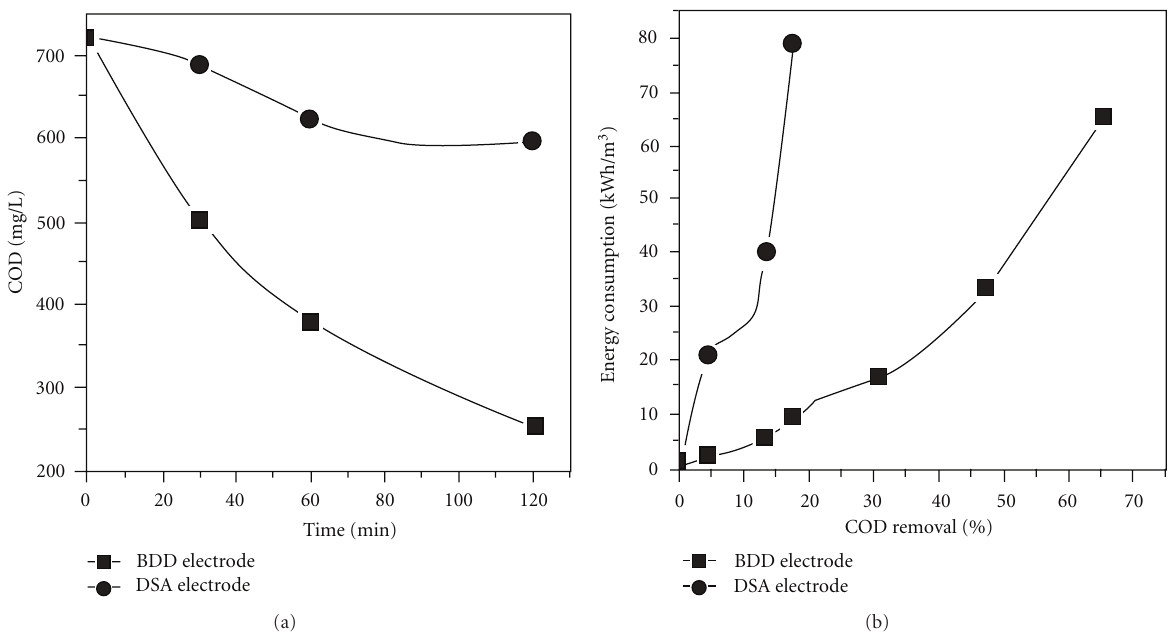
Figure 15: (a) Comparison of the evolution of COD during electrochemical treatment; (b) evolution of the specific energy consumption against COD removal during electrochemical treatment of acrylic fiber wastewater on DSA and BDD electrode. Conditions: applied current: 0.50A, flow rate: 400 mL/min, T = 45 ± 1 ◦ C